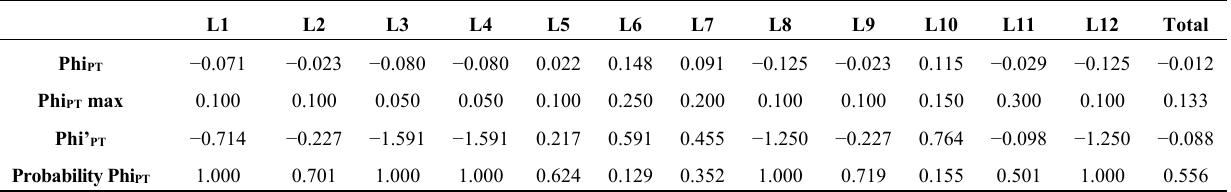
Table 6. Analysis of molecular variance by locus. Number of samples = 10, number of populations = 2, number of regions = 1, number of permutations = 999. Probability for Phi PT is based on standard permutation across the full data set. Phi PT = AP/(WP + AP) = AP/TOT (AP = estimated variation among populations, WP = estimated variation within